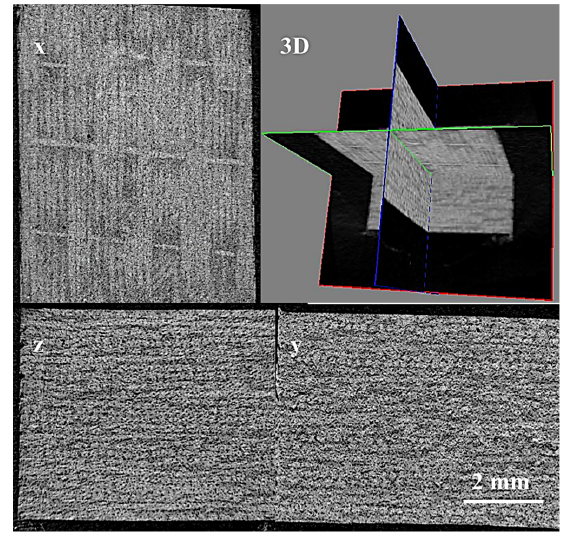
Figure 1. The 3D and cross section scanning images of the PC120 sample.